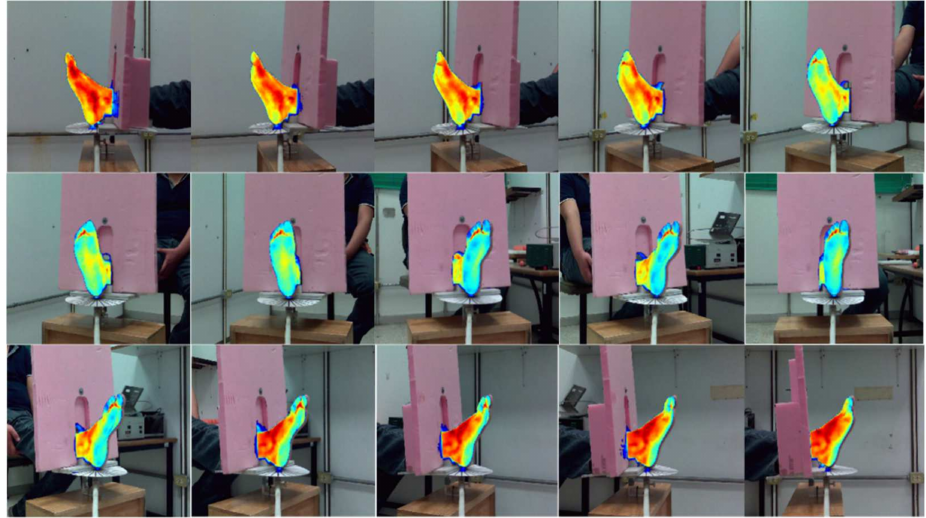
Figure 18. Set of 15 merged image pairs used for determining the 3D point cloud. Although every radiometric data array has a dimension of 320 × 240, the RoI has a different dimension depending on the angle of capture, as noticeable in the first columns of “Image set S1” and “Image set S2” of Table 6. The percentages of these RoI pixels generally represent less than one-third of the original matrix size. Consequently, all 76,800 values are not processed or involved in the superimposition